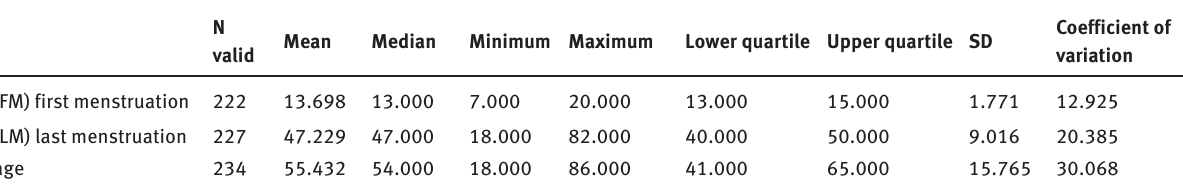
Table 3: Age distribution of first and the last menstruation in the whole study group.